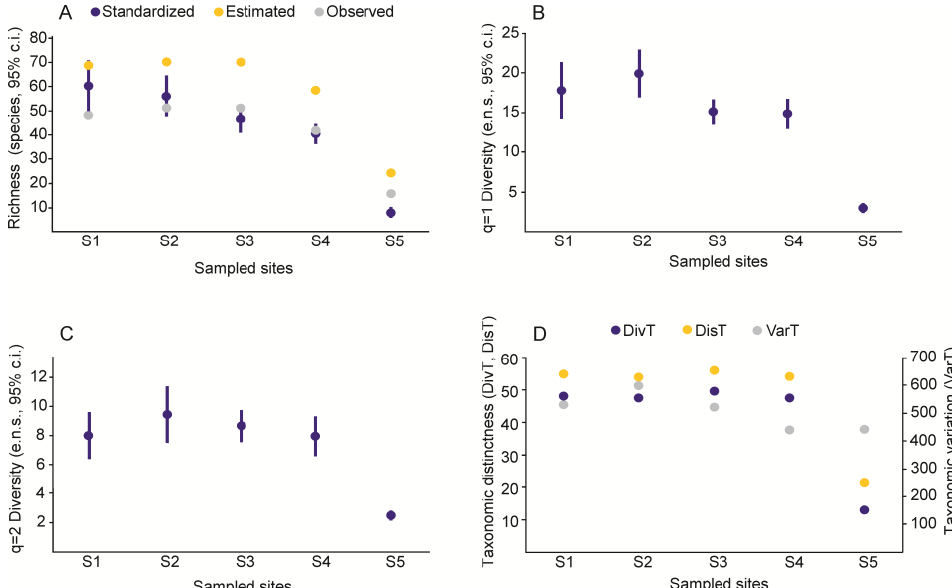
Figure 4. Species richness and diversity of orders 1 and 2 and taxonomic distinctness indices for each of the sampled sites. ( A ) Species richness, ( B ) Order q = 1 diversity, ( C ) Order q = 2 diversity, ( D ) Taxonomic distinctness (DivT), average taxonomic distinctness (DistT), and taxonomic variation (VarT). For standardized diversity values, error bars are 95% confidence intervals (c.i.), and for q = 1 and q = 2 diversities, the units are the effective number of species (e.n.s.).